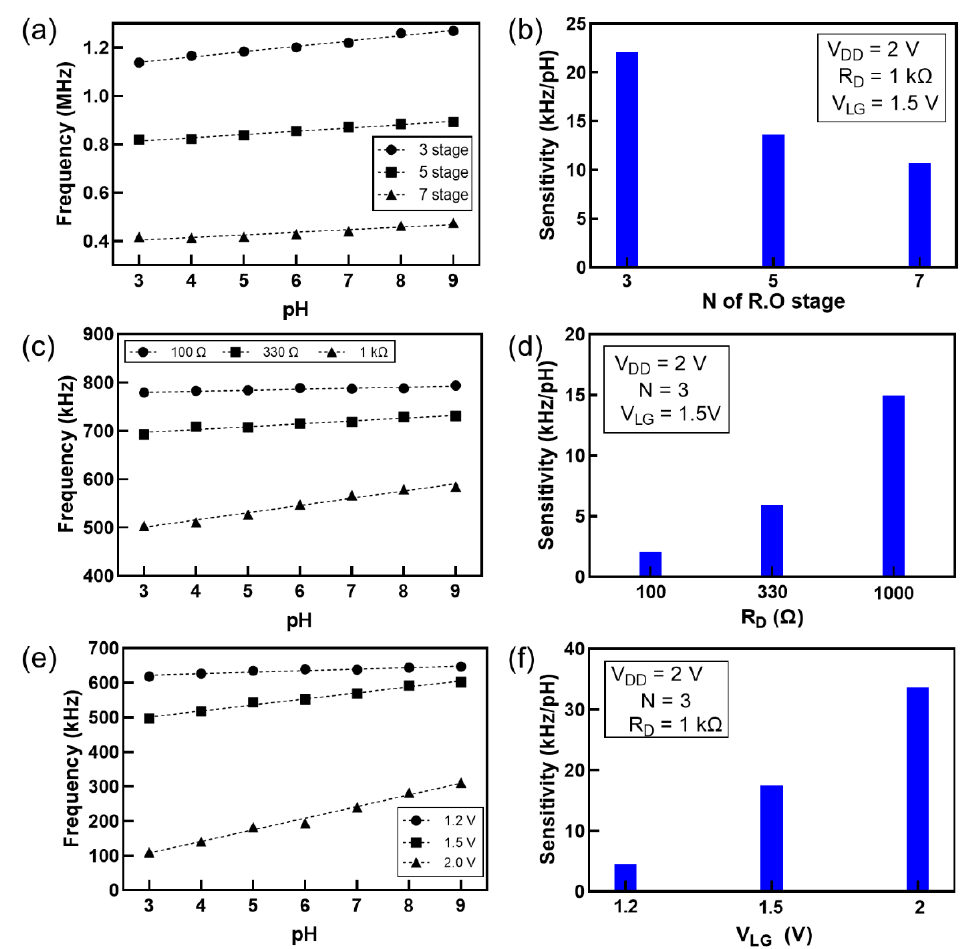
Figure 3. Effects of circuit parameters on sensitivity. ( a ) Oscillation frequency vs. pH for different numbers of stages ( N ). ( b ) Dependence of sensitivity on N . ( c ) Oscillation frequency vs. pH for different values of load resistance ( R D ). ( d ) Dependence of sensitivity on R D . ( e ) Oscillation frequency vs. pH for different values of liquid-gate voltage ( V LG ). ( f ) Dependence of sensitivity on V LG .